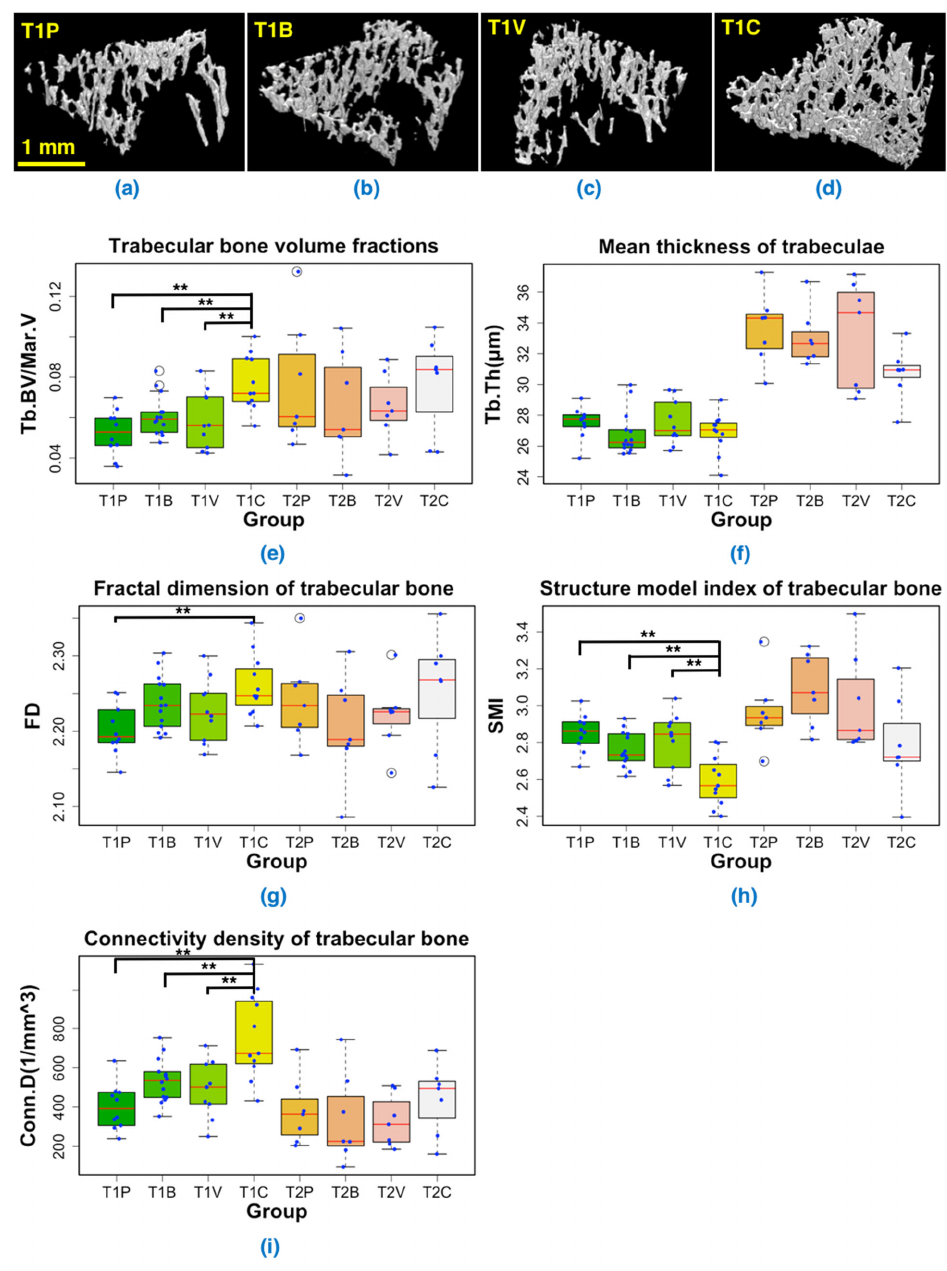
Figure 6. Analysis of trabecular bone in the tibial metaphysis. ( a – d ) 3D renderings of trabecular bone in T1P, T1B, T1V, and T1C. ( e ) Boxplot of trabecular bone volume fractions (Tb.BV/Mar.V). ( f ) Boxplot of the trabecular bone thickness (Tb.Th). ( g ) Boxplot of fractal dimension (FD). ( h ) Boxplot of structure model index (SMI). ( i ) Boxplot of connectivity density (Conn.D). Asterisk ** denotes statistically significant difference, at p = 0.05 level. Individual data are plotted as blue dots within the box plots. T1 and T2 denote the first and second time points, respectively. (P: Placebo, B: Bevacizumab, V: Vatalanib, C: Combination of Bevacizumab and